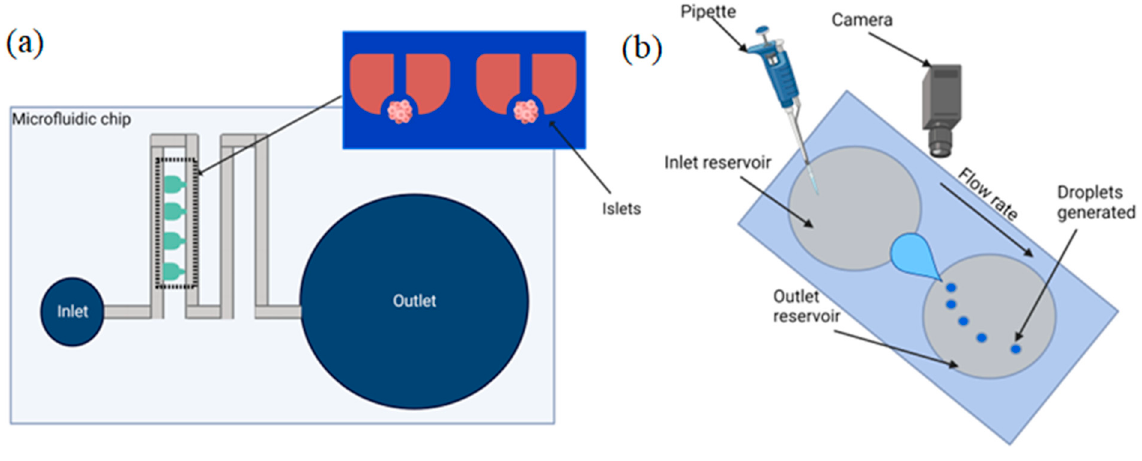
Figure 2. Schematics of microfluidic systems with surface tension flow rate regulation: ( a ) microfluidic array to study Langerhans pancreatic islets; ( b ) schematics of droplet microfluidic system.